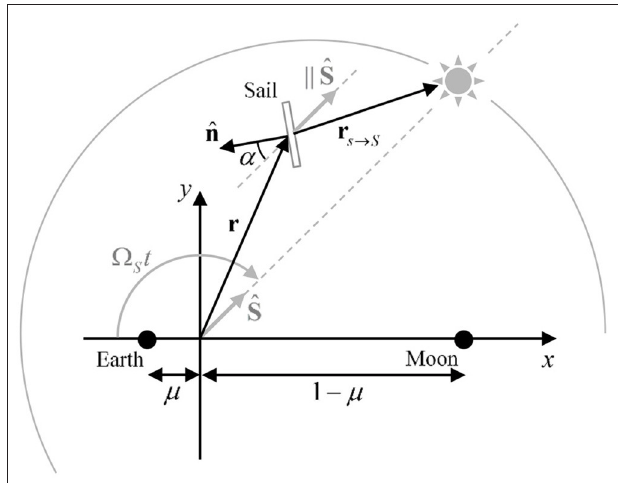
FIGURE 1 | Schematic of top view of solar-sail Earth-Moon circular restricted three-body